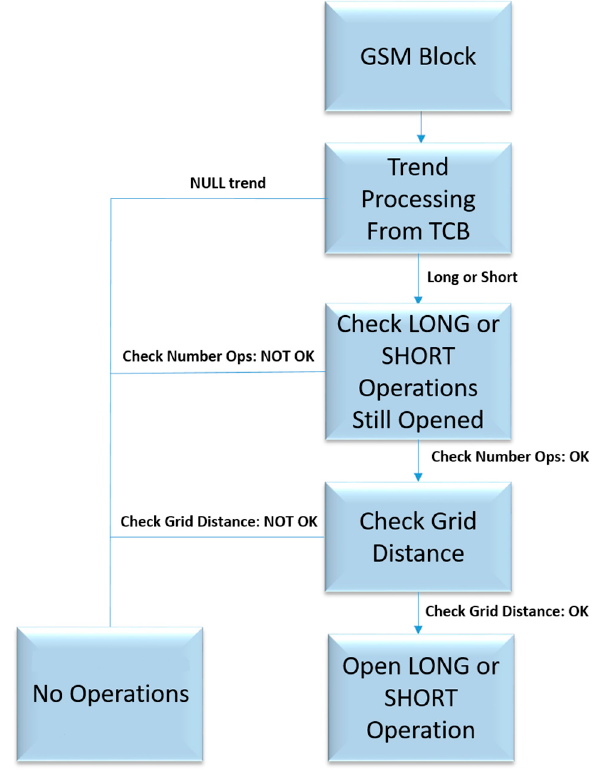
Figure 5. The grid system manager (GSM) block: The workflow.